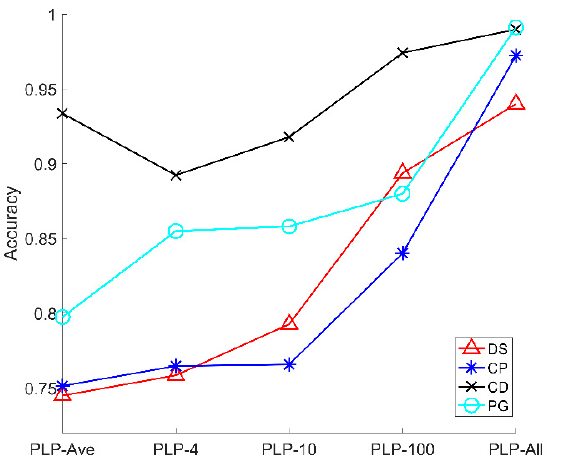
Figure 7. The average accuracy of five polarized light pulses processing methods for signal